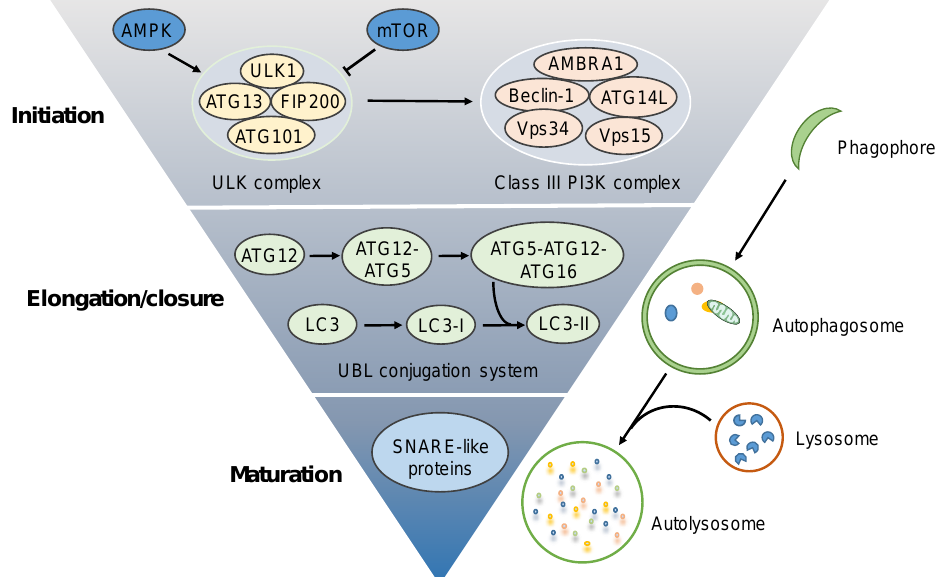
Figure 1. Autophagy machinery. The autophagy process involves initiation, elongation/closure and maturation. The autophagy process is initiated by autophagosome biogenesis to form phagophore, which is regulated by the activation of the preinitiation complex (also known as the ULK complex, containing ULK1/2, ATG13, FIP200, and ATG101) and subsequent activation of the initiation complex (also called the class III PI3K complex, consisting of VPS34, VPS15, Beclin 1, ATG14L, and AMBRA1). The phagophore is then elongated and closed to form a double-membrane autophagosome, which is tightly regulated by the ubiquitin–like (UBL) conjugation systems. The autophagosome will fuse with a lysosome to form an autolysosome for degradation. The SNARE-like proteins may play important roles in autophagosome–lysosome degradation. AMPK — 5′-AMP-activated protein kinase; mTOR — the mammalian target of rapamycin; ULK1 — UNC51-like kinase 1; class III PI3K — the class III